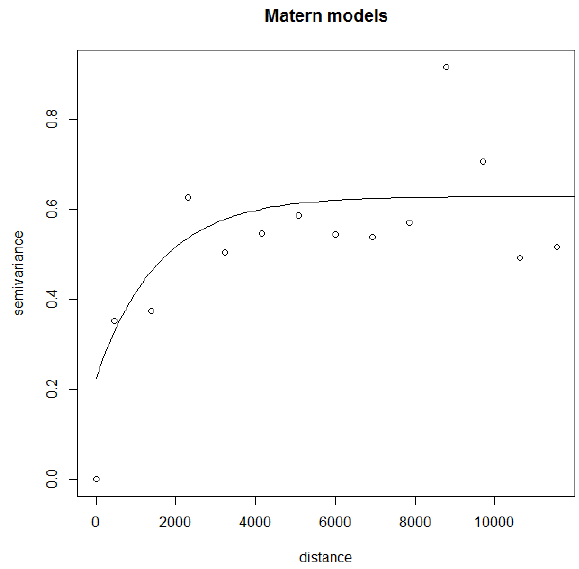
Figure 5: Model of adjusted Matern semivariogram